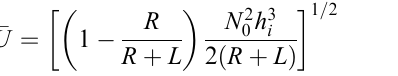
Figure 4a, b shows the mesoscale available potential energy and the mean wind intensity as computed by Eqs. (7) and (8). The CBL heights are 1.0, 1.5 and 2.0 km, respectively, L ranges from 0 to 200 km. The sea-breeze intensity grows as the boundary layer height increases and as the width of the peninsula increases, to reach its maximum when L (cid:136) R , the flow intensity ranges from 2.5 to 5.5 ms (cid:255) 1 when the boundary layer ranges from 1 to 2 km.